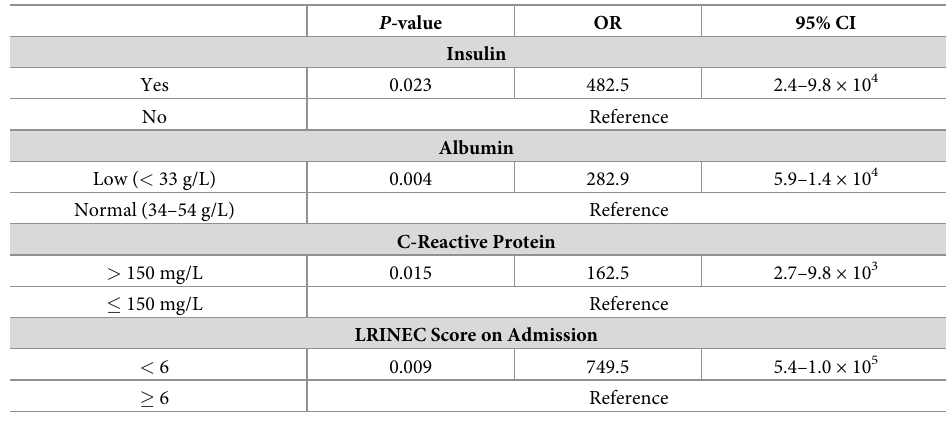
Table 3. Multivariant analysis for factors associated with failed transmetatarsal amputations in diabetic